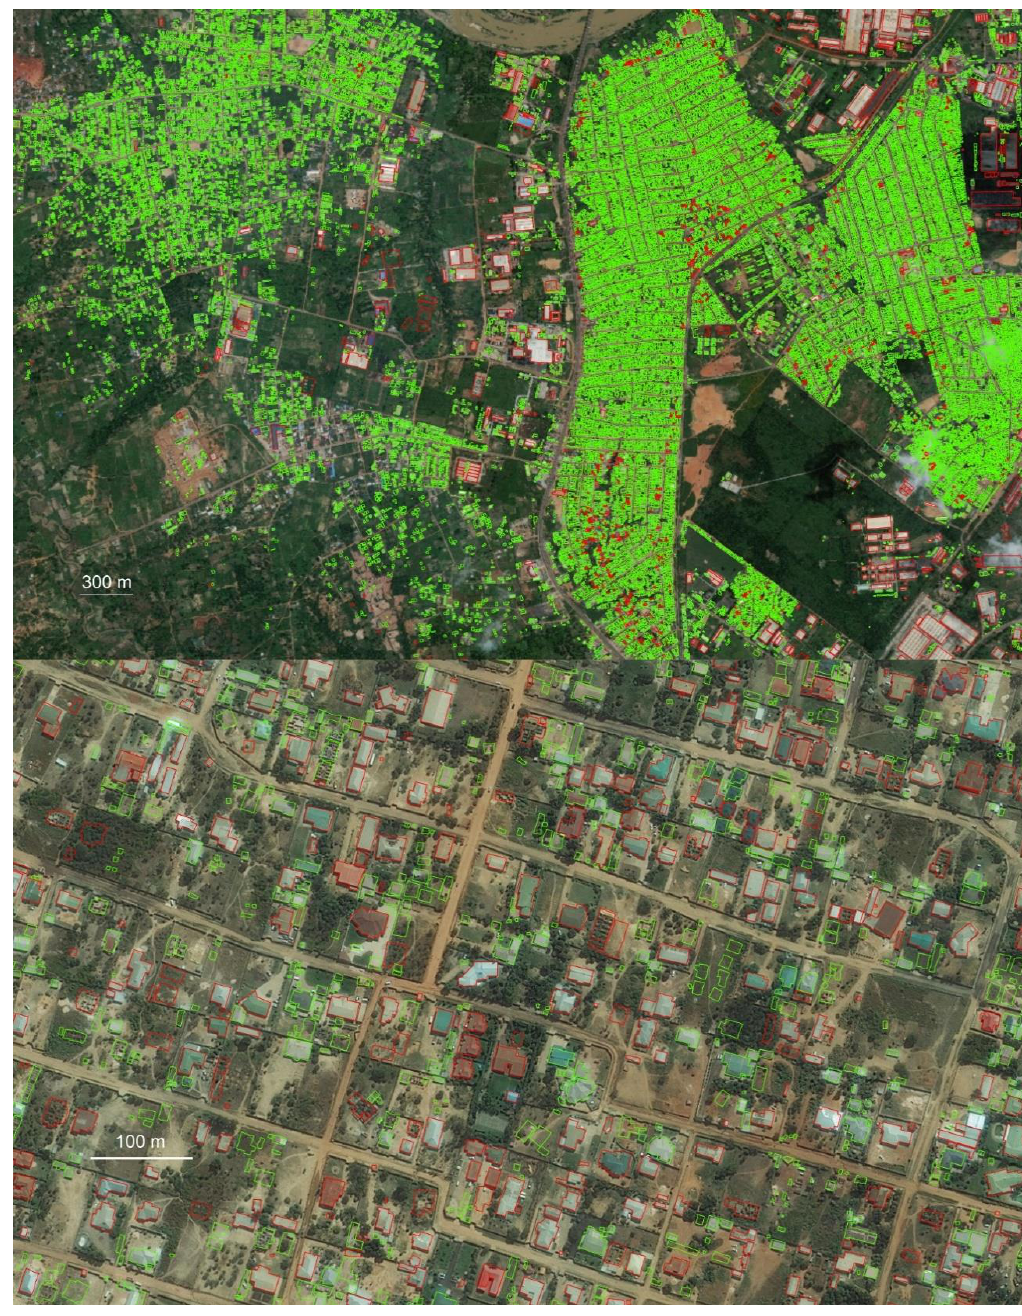
Figure 5. Visualisations of classified residential (depicted in green) and nonresidential (red) building footprints, ( Top ) South-western Kaduna, Nigeria (co-ordinate location 7.390E, 10.470N; scale 1:16,000). The classification performance of the building classification model is observed to be generally effective at ‘neighbourhood’ scale (see text). ( Bottom ) North-western Lubumbashi, the Democratic Republic of the Congo (co-ordinate location 27.436E, 11.648S; scale 1:2700). A predominantly residential suburban locality at ‘street’ scale, demonstrating apparent building misclassifications (i.e., nonresidential) despite excellent statistical performance of the model (see text) (DigitizeAfrica data © 2020 Maxar Technologies, Ecopia.AI; © 2020 OpenStreetMap